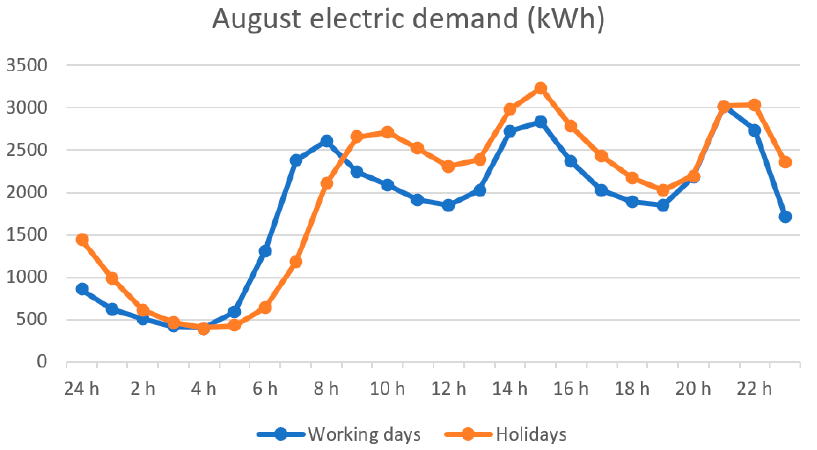
Figure 3. Hourly electricity demand for the month of August. Note: vertical axis shows average energy demand in MWh, while horizontal axis the hours of a day.